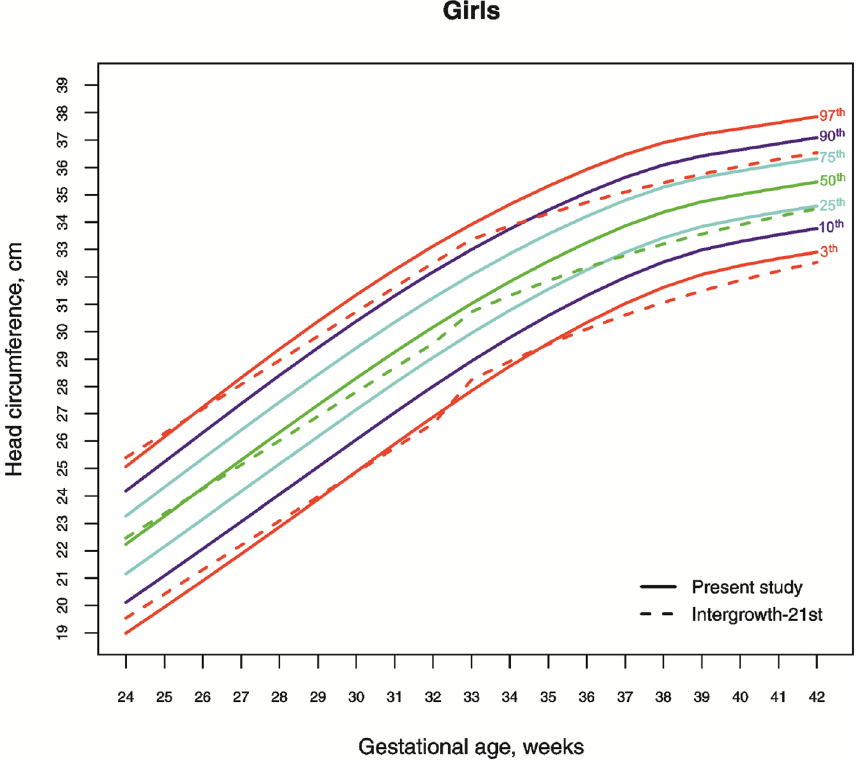
Figure 2. The 3rd, 10th, 25th, 50th, 75th, 90th and 97th smoothed percentile curves for head circumference (cm) in Lithuanian neonate girls and the 3rd, 50th and 97th percentiles for INTERGROWTH-21st 20,25 .